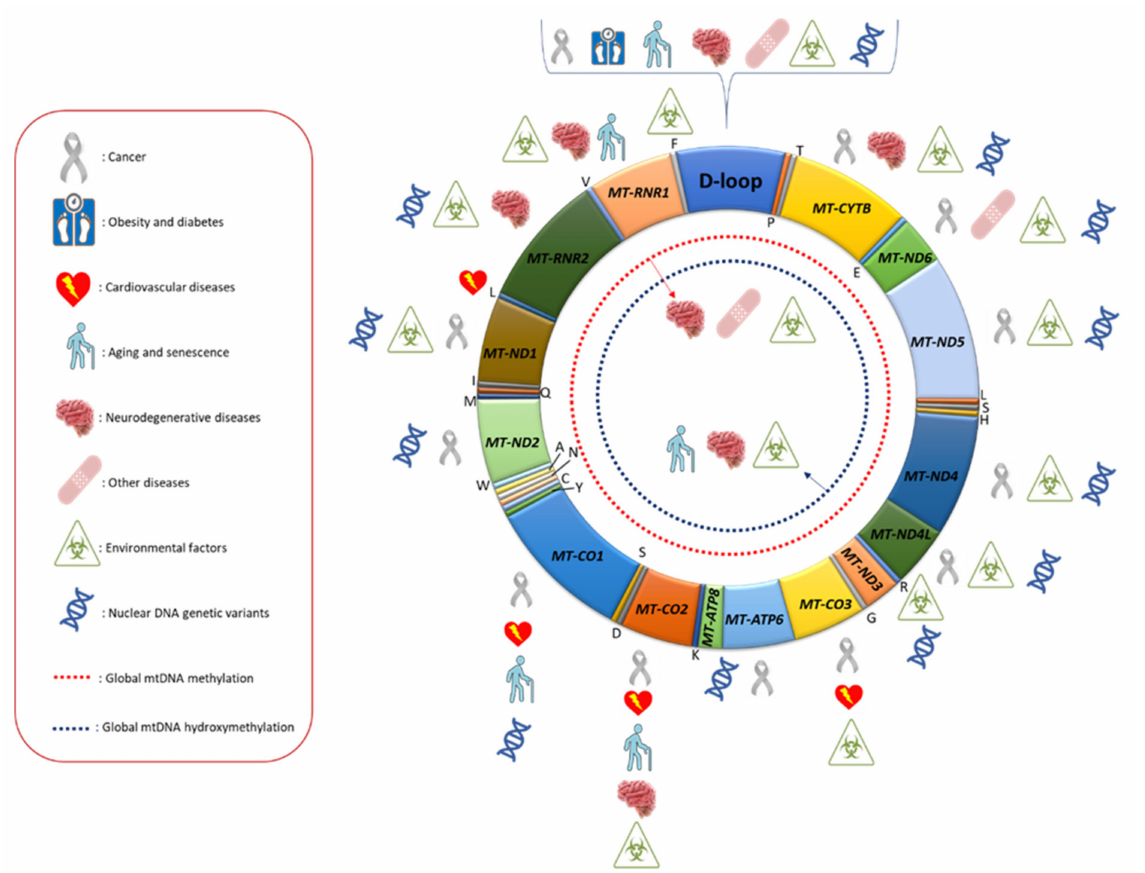
Figure 1. Mitochondrial DNA regions whose methylation levels were found to be associated with different human diseases, environmental factors and nuclear DNA genetic variants. In the red box, the meaning of the symbols used is